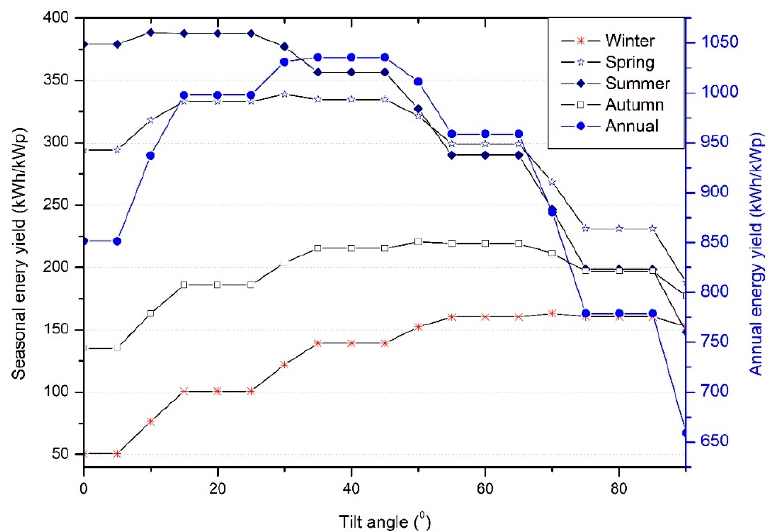
Figure 7. Seasonal and annual yield of 1 kWp Si panel calculated at different tilt angle and azimuth = 0° for Flanders, Belgium.